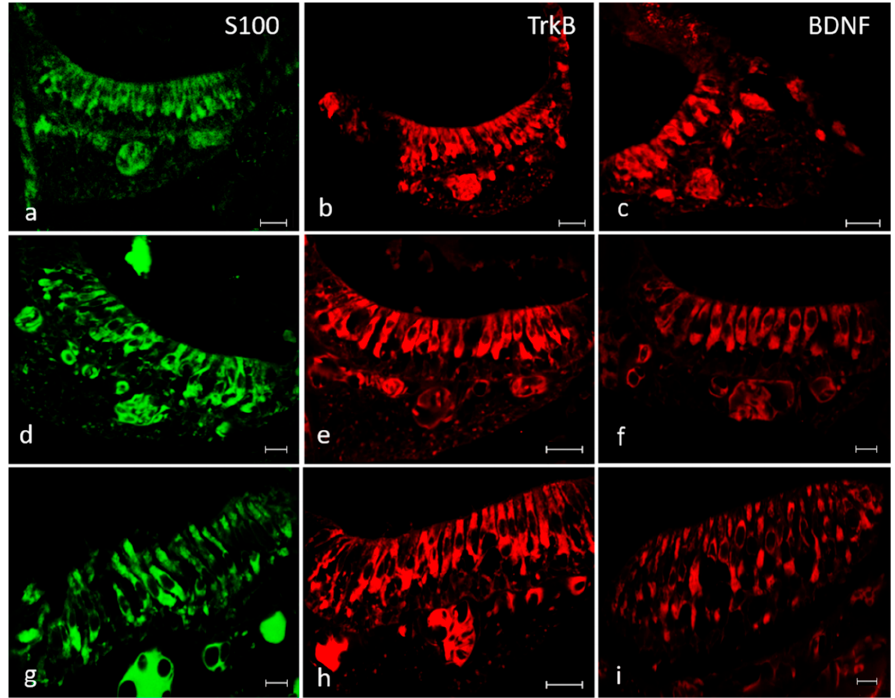
Figure 9. Inner ear of adult zebrafish. Immunohistochemical detection of S100 protein* in the macula of the utricle ( a ), saccule ( d ) and lagena ( g ), of TrkB in the macula of the utricle ( b ), saccule ( e ) and lagena ( h ). Immunohistochemical detection of BDNF in the macula of the utricle ( c ), saccule ( f ) and lagena ( i ). The utricular and saccular maculae consist of a cylindrical epithelium formed by sensory hair, supporting, mantle and basal cells. Cytoplasmic immunoreactivity for these antibodies was found in the sensory epithelial cells of the utriculus, sacculus and lagena. Scale bars = 10 µ m ( a , c , d , f , g , i ). Scale bar s = 20 µ m ( b , e , h ). The authors specify that the green channel was chosen to di ff erentiate the immunofluorescence for protein